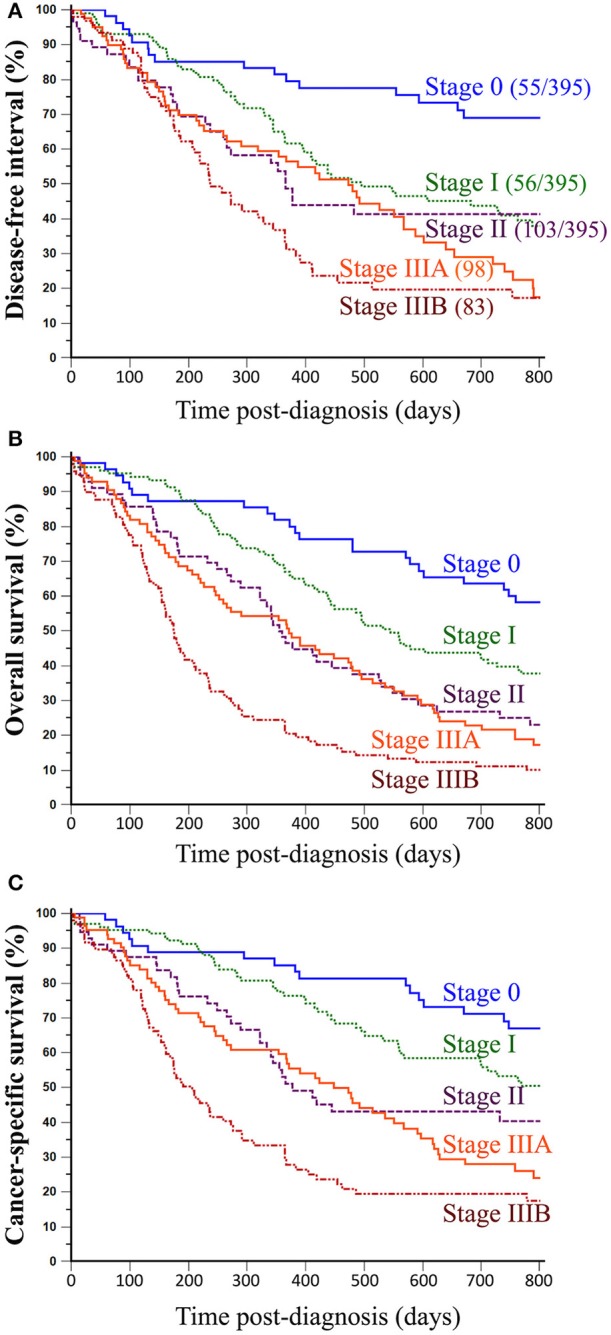
Association between histological stages of FMCs and outcomes of feline patients. (A) Disease-free interval. The probability of locoregional recurrence and/or distant metastasis was very low for stage 0 FMCs, moderate for stage I–II FMCs, and high for stage IIIA–IIIB FMCs. (B) Overall survival. All-cause mortality of female cats with mammary carcinoma significantly increased with increasing histological stage at presentation, although there was poor separation between stage II and stage IIIA FMCs. (C) Cancer-specific survival. The probability of dying from cancer significantly increased with histological stage. Kaplan-Meier curves. See Table 4 for corresponding hazard ratios and p-values.